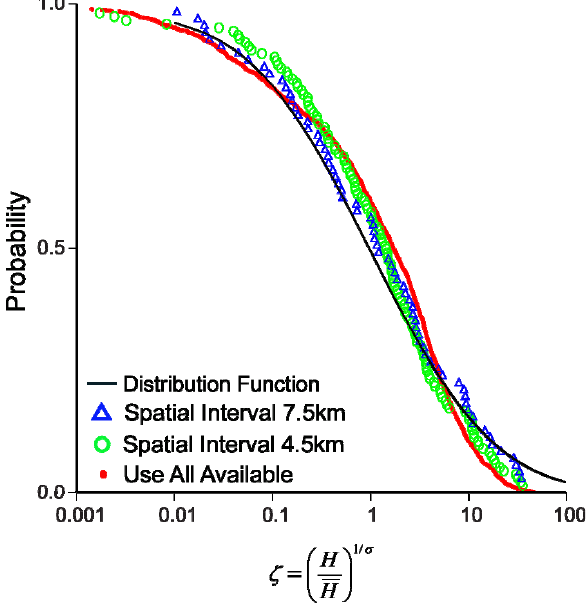
Fig. 4. Cummulative distribution (probability) of the 2011 Tohoku- Figure 4. Cummulative distribution (probability) of the 2011 Tohoku-oki tsunami in 4 oki tsunami in dimensionless form. The dashed line corresponds dimensionless form. The dashed line corresponds to the log-normal curve. Circles and 5 to the log-normal curve. The circles and triangles represent spatial triangles represent spatial intervals of 4.5 km and 7.5 km, respectively. Dots indicate the 6 intervals of 4.5km and 7.5km, respectively. The dots indicate the individual observed values (over individual observed values (over 2,000). 7 8